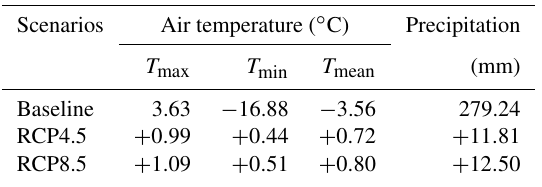
Table 1. Projected climatic changes (precipitation and maximum, minimum, and mean air temperature) under the RCP4.5 and RCP8.5 scenarios in 2044 compared with the corresponding values in the baseline data